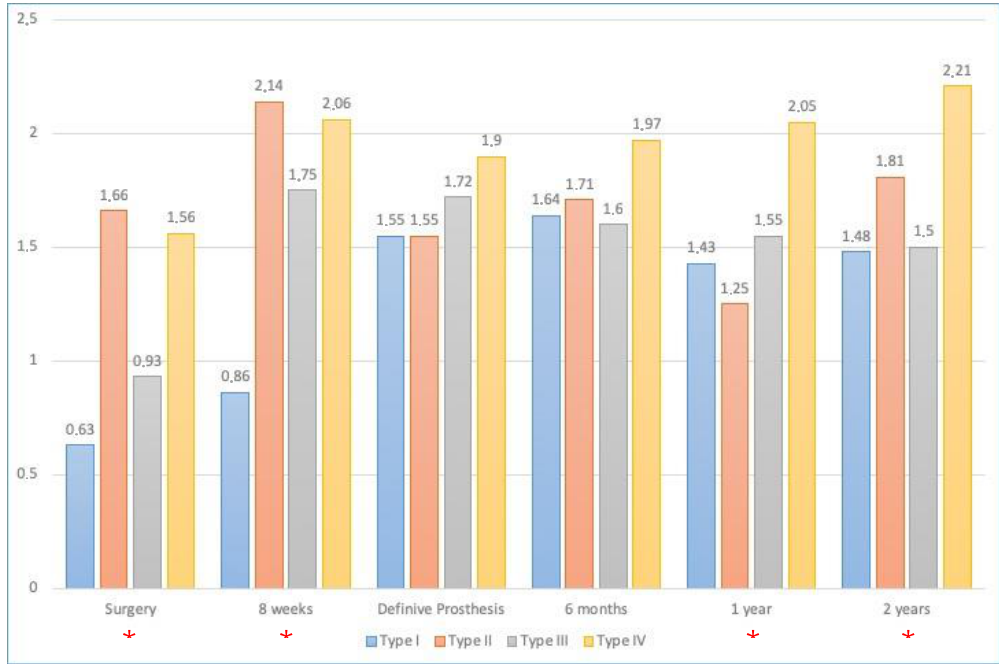
Figure 6. SCD (in mm) according to the moment of implant placement. * Statistically significant differences ( p < 0.05).